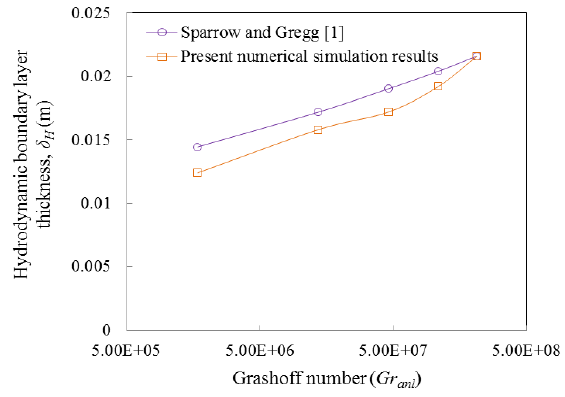
Figure 5. Comparison of velocity profiles of different fluids at location x = 0.5 m